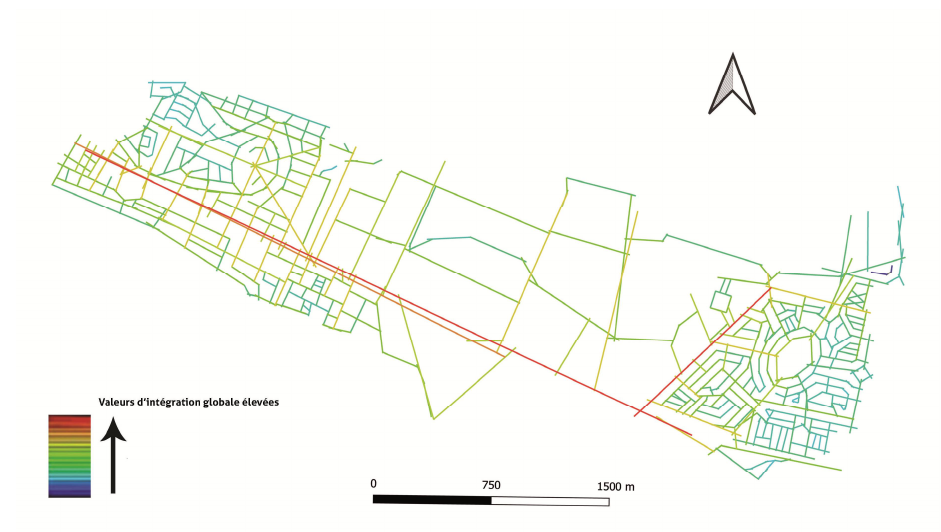
Figure 6. Global Integration (HH) map of Hammem Chott. ‘Avenue de la Terre’ presents the second highest level of integration. It is an interme- diate value between the most integrated axis RN1 and the adjacent spatial system of lines of low integration to the axial lines serving to the Higher Institute of Cultural Animation of Bir El Bey on the one hand and the sports complex of Borj Cedria on the other hand. The location of the forest, in direct contact with two axes mentioned, gives it an important accessibility. This can be justified by its proximity to urban areas of dense construction, including residential areas, and significant populations go there other than by car. The segregated areas include the peripheral roads of El Farabi Street in the northwest- ern sides. They are in the [1.409; 1.681] and [1.681; 1.953] range and are more segregated than the overall urban system (Table 1). We find in the segregated areas the Higher Institute of Cultural Animation of Bir El Bey and a touristic area. The segregation is accentuated in the northwestern part of the city (roads 17, 18, and 19), mainly the collective housing area. This map is dominated by a strong opposition effect between the center (high val- ues) and the periphery of the city (low values), without any local hierarchy between the types of